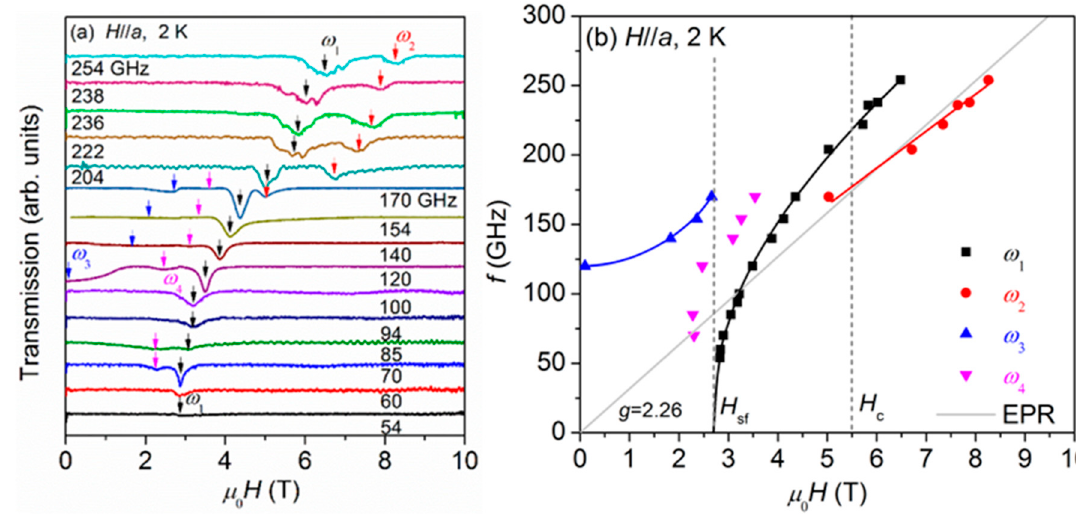
Figure 3. ( a ) Frequency-dependent ESR spectra measured at 2 K for the easy a axis. ( b ) Frequency-field ( f - H ) relationship at 2 K as well as the EPR line. The solid lines are guides for the eyes.